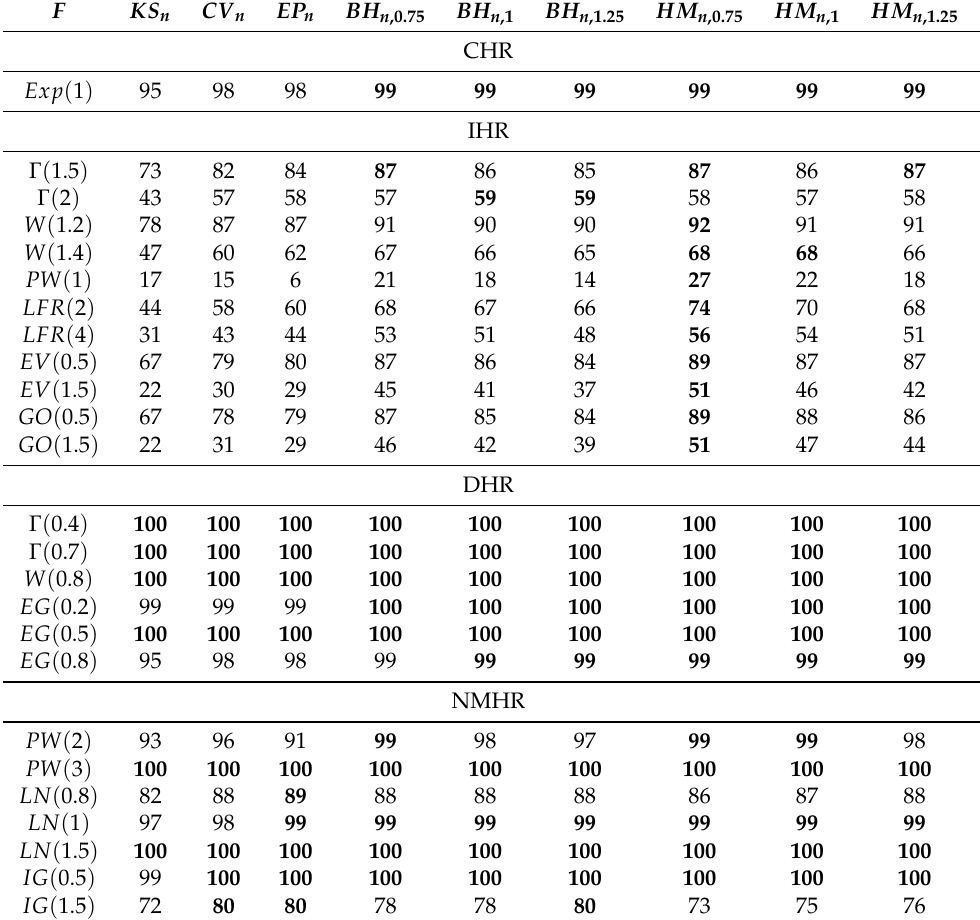
Table 7. Estimated powers for general alternatives for the exponential distribution for sample size n =